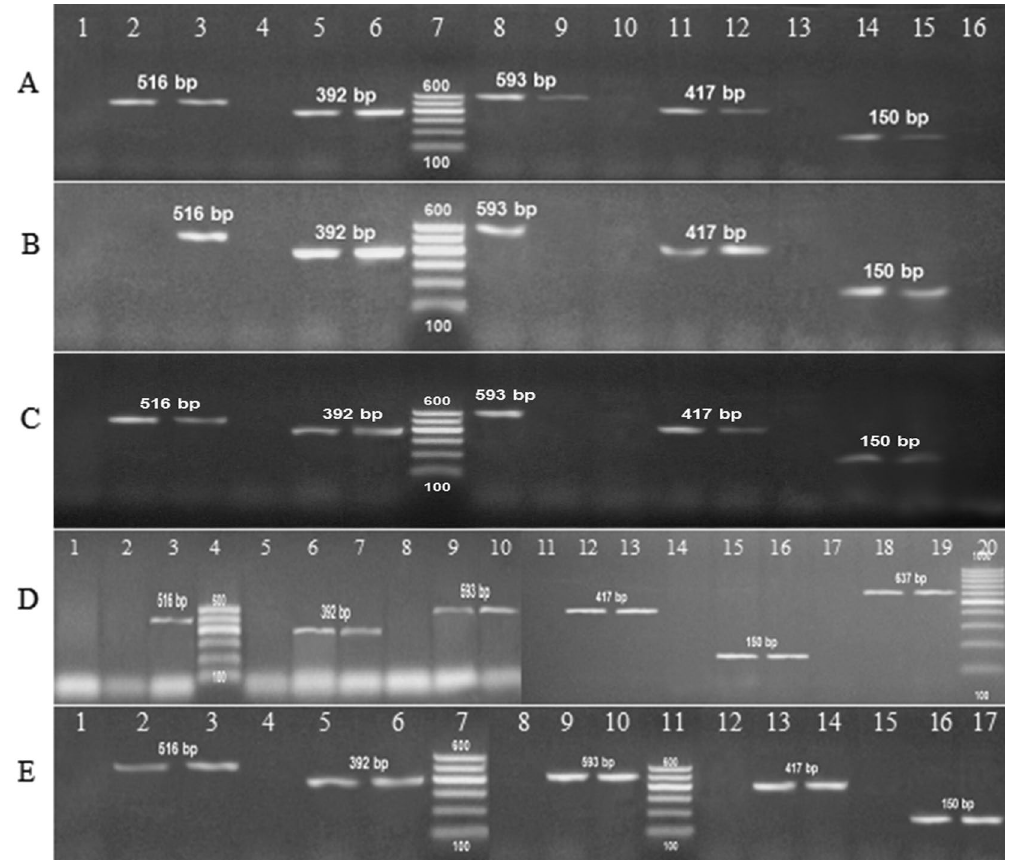
Figure 2. 1.5% agarose gel electrophoresis of multiplex PCR of antibiotic resistant genes for the isolated uropathogens. ( A ) E. coli ; ( B ) Klebsiella pneumoniae ; ( C ) Proteus mirabilis ; Lane 1, 4, 10, 13 and 16: Negative control for detected genes; Lane 3, 6, 8, 11 and 14: Positive control of DNA confirmed by reference laboratory for quality control; Lane 7: 100 bp ladder as molecular size DNA marker (cat. no. 239035) supplied from QIAGEN (USA). Lane 2 bla TEM (516 bp); Lane 5 bla SHV (392 bp); Lane 9 bla CTX (593 bp); Lane 12 qnr S (417); Lane 15 aac (3)-Ia (150 bp). ( D ) Pseudomonas aeuroginosa ; Lane, 1, 5, 8, 11, 14 and 17: Negative control for detected genes; Lane 3, 7, 10, 13, 16 and 19: Positive control of DNA; Lane 2 bla TEM ; Lane 6 bla SHV ; Lane 9 bla CTX ; Lane 12 qnr S; Lane 15 aac (3)-Ia; Lane 18 mex R (637 bp). Lane 4: 100 bp ladder as molecular size DNA marker (cat. no. 239035) supplied from QIAGEN (USA). Lane 20: Gene ruler 100 bp DNA ladder (cat. no. SM0243) supplied from Fermentas. ( E ) Acinetobacter baumanii; Lane 1, 4, 8, 12, 15: Negative control for detected genes; Lane 3, 6, 10, 14 and 17: Positive control of DNA; Lane 2 bla TEM ; Lane 5 bla SHV ; Lane 9 bla CTX ; Lane 13 qnr S; Lane 16 aac (3)-Ia. Lane 7 and 11: 100 bp ladder as molecular size DNA marker (cat. no. 239035) supplied from QIAGEN